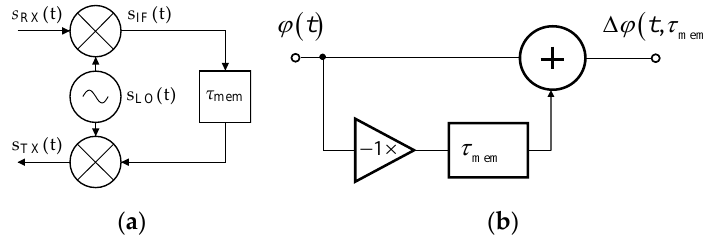
Figure 5. ( a ) Simplified schematic of TS used for the LO phase noise propagation analysis. ( b ) Equivalent circuit of the LO phase noise propagation.